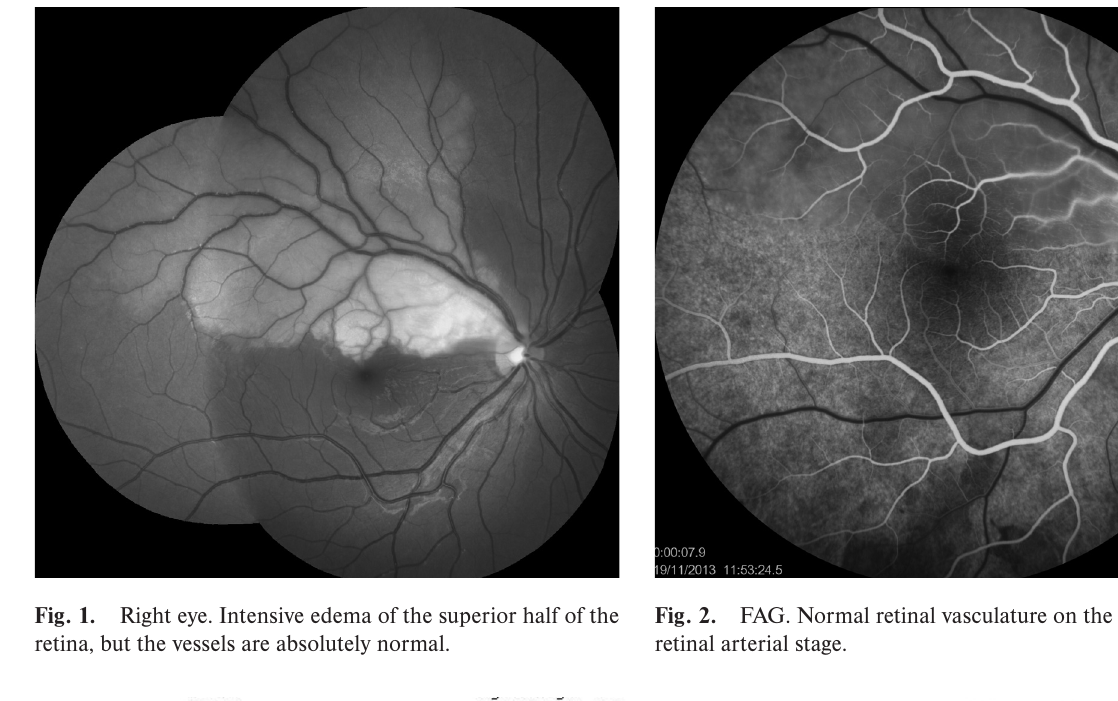
were observed in the superior half of the foveal